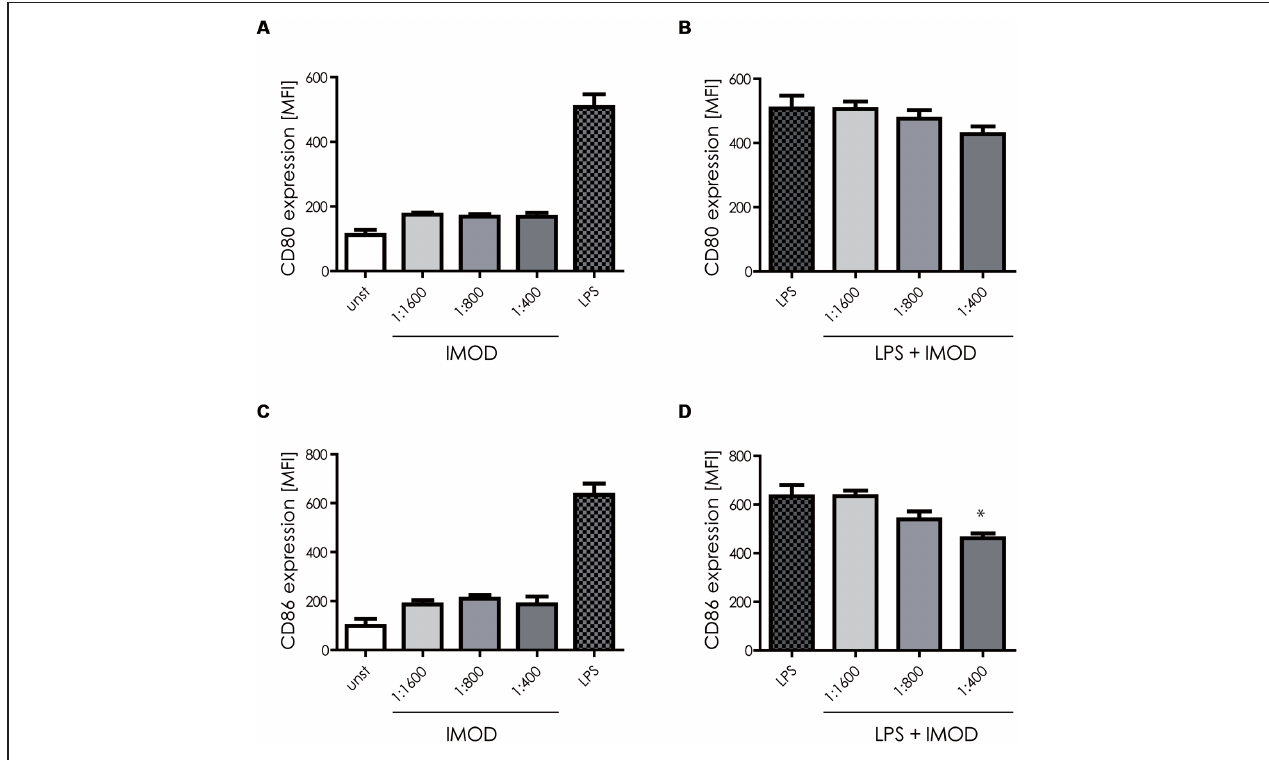
FIGURE 1 |IMOD treatment does not affect dendritic cell (DC) maturation. Immature DCs were stimulated with different dilutions of IMOD in the presence or absence of LPS. 18 h after stimulation, expression of maturation markers